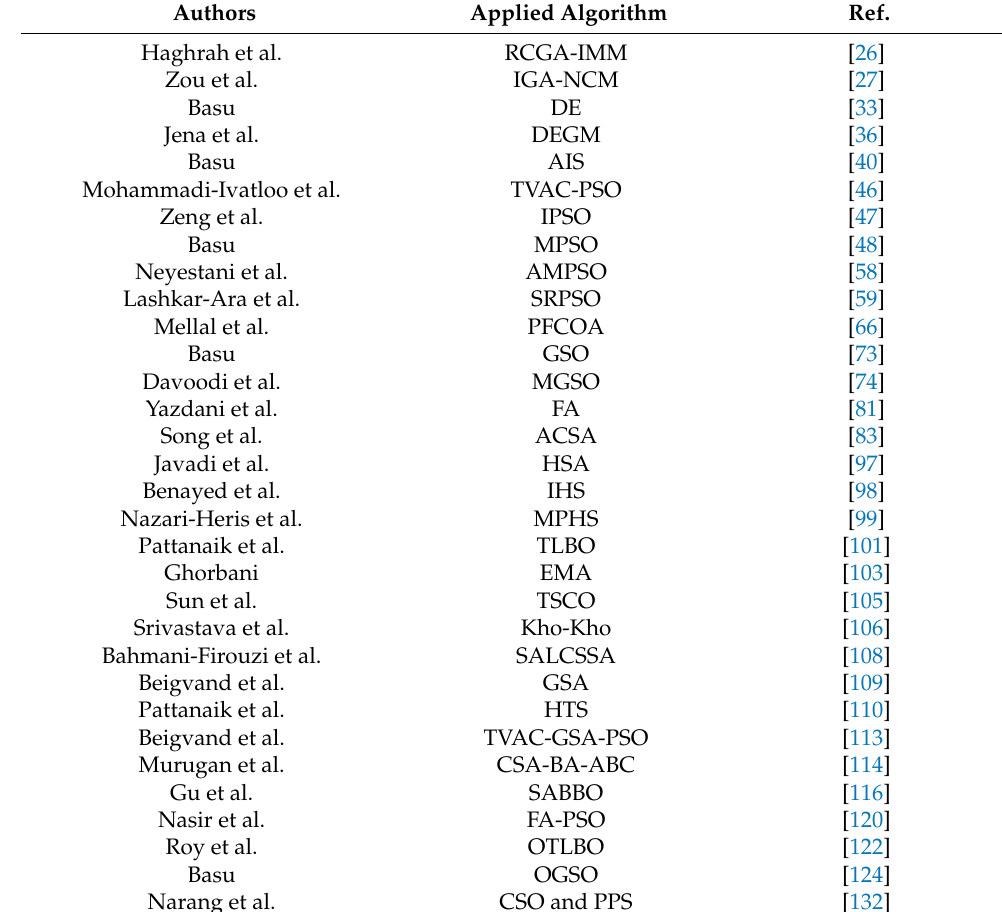
Table 5. Economic dispatching issues of CHP energy systems (CHPED optimization